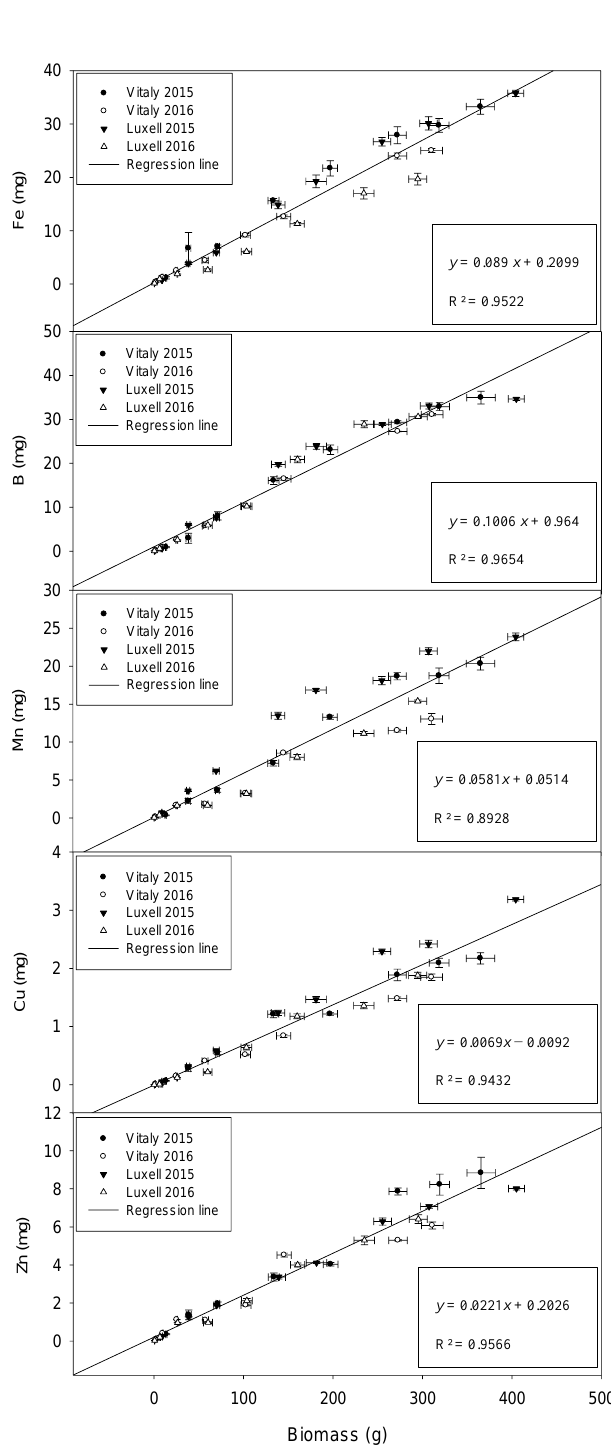
Figure 3. Linear relationship between the accumulated Fe, B, Mn, Cu, and Zn and the biomass of both Vitaly and Luxell varieties obtained from the 2015 to 2016 cycles. Data are the mean of four replicates ± standard error of the mean. The lineal model is included and the corresponding determination coefficient (R 2 ).